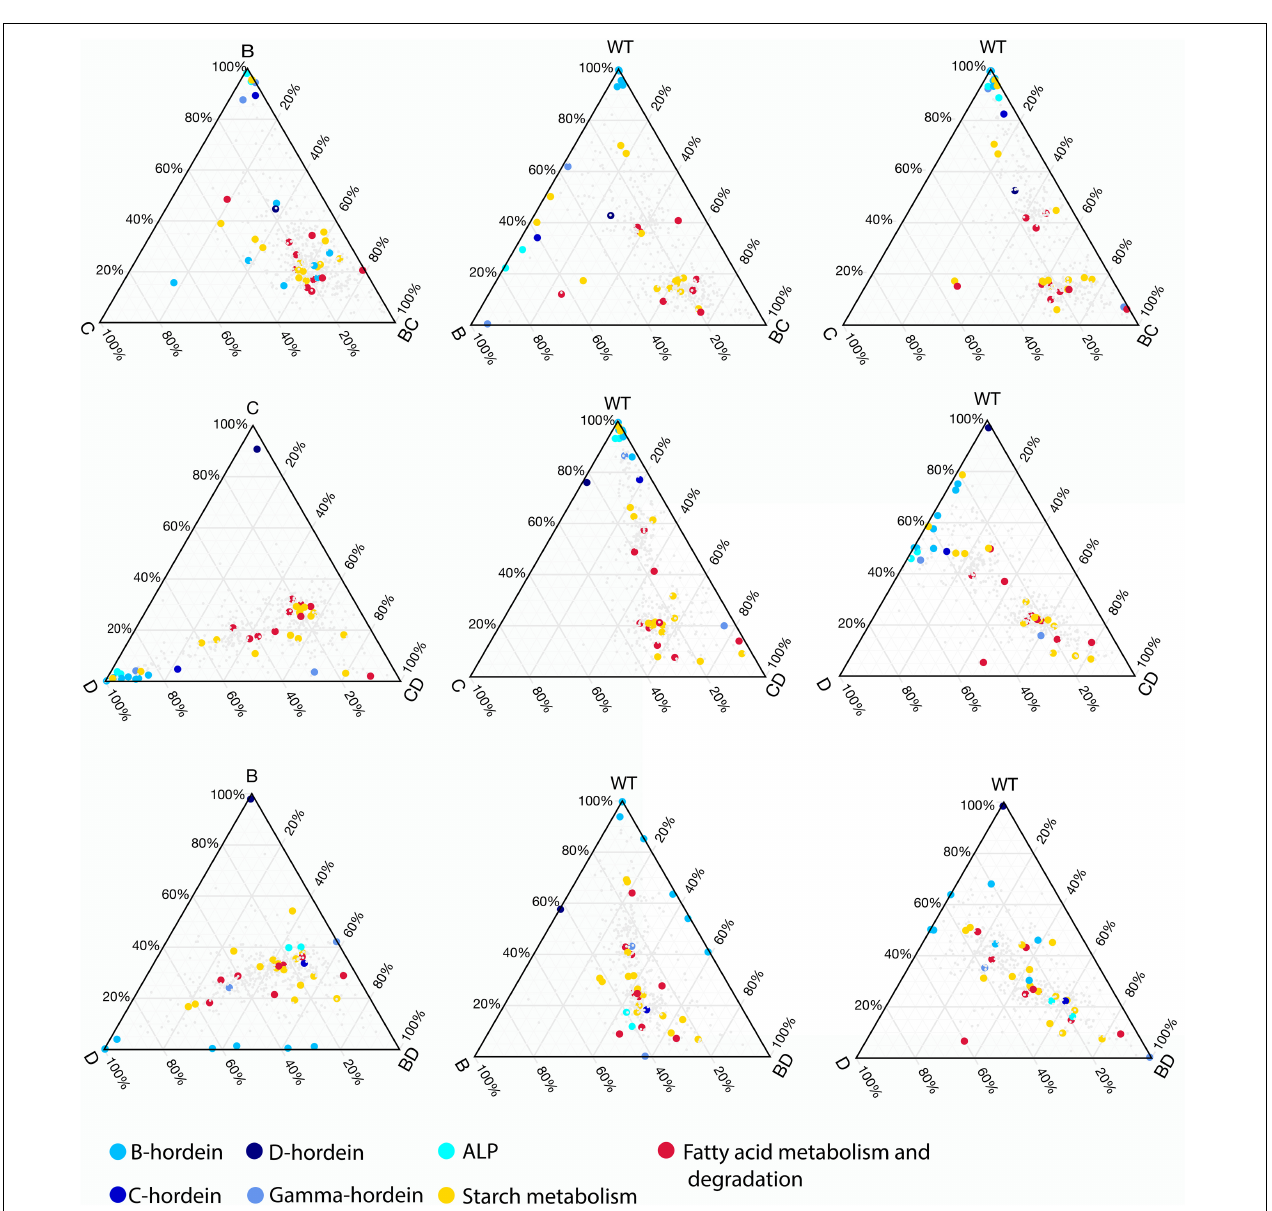
FIGURE 5 | Changes in relative abundance patterns in the double-mutant and parent lines. Ternary plots were constructed to highlight relative abundance differences between DMs, SMs, and WT. For each DM three plots are presented representing DM and SM relationships followed by DM, WT relationships combined with the presence of one of the SM parents. The colours highlight the different hordeins, starch metabolism, fatty acid metabolism and degradation associated